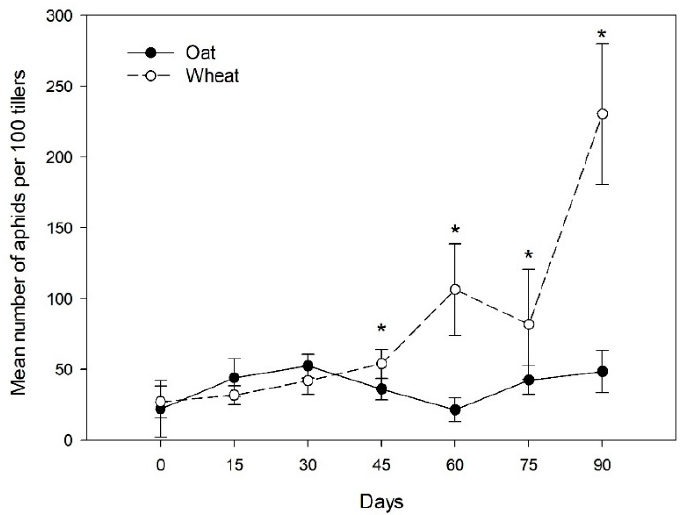
Figure 1. Aphid abundance on different host plants across the season. Mean number of aphids ( ± SE) on oat and wheat fields in the different sampling dates across one season. * Represents significant differences in the aphid abundance between host plants.